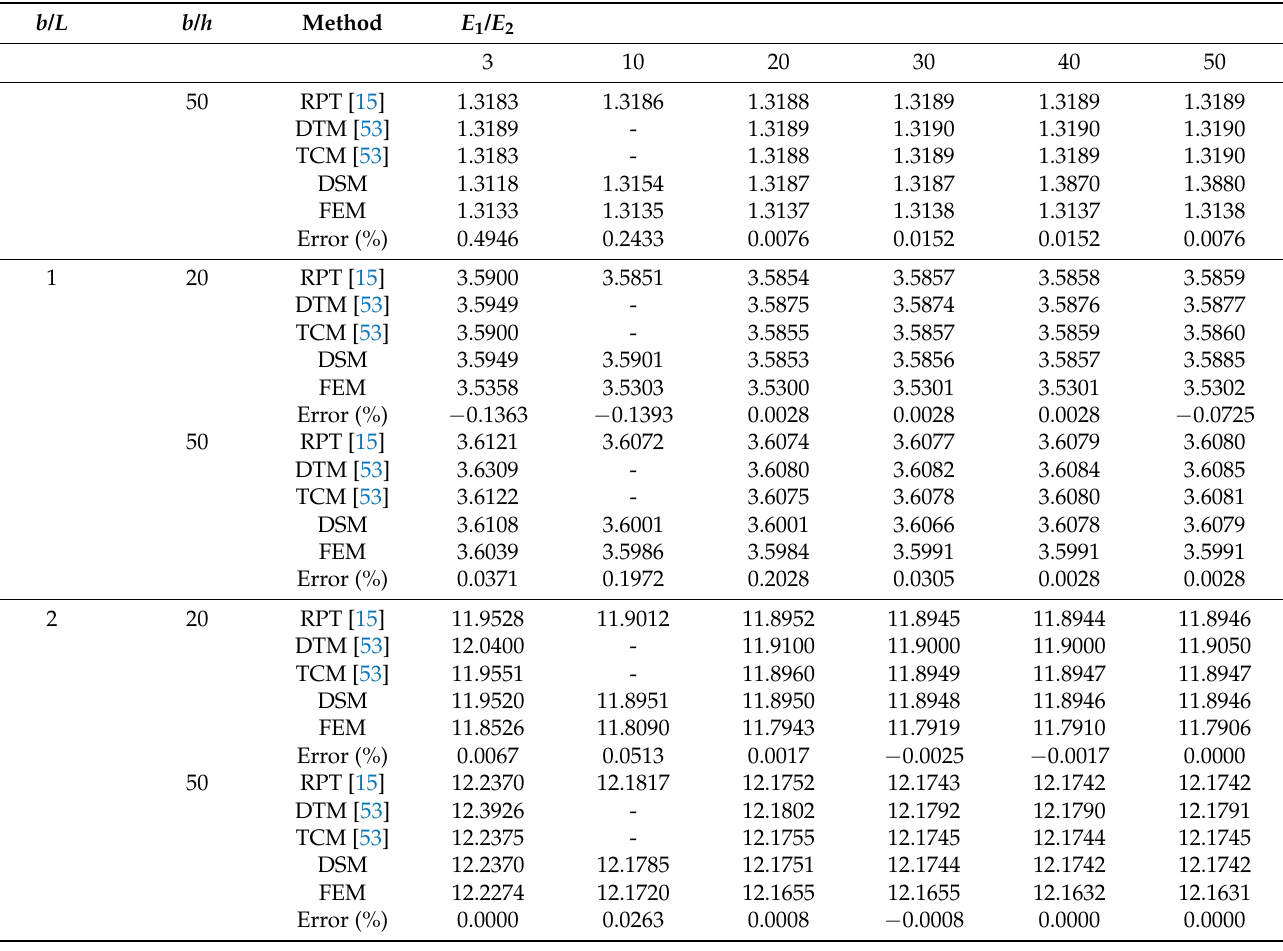
(cid:113) ρ (cid:16) (cid:17) (cid:118) = ω b 2 of an orthotropic E 2 h